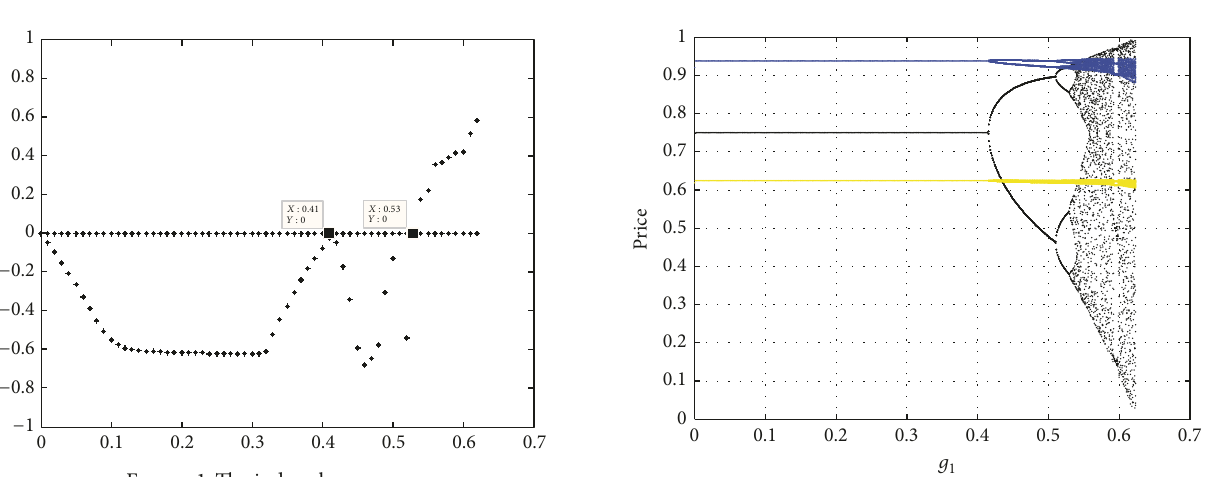
Figure 1: The index change map.